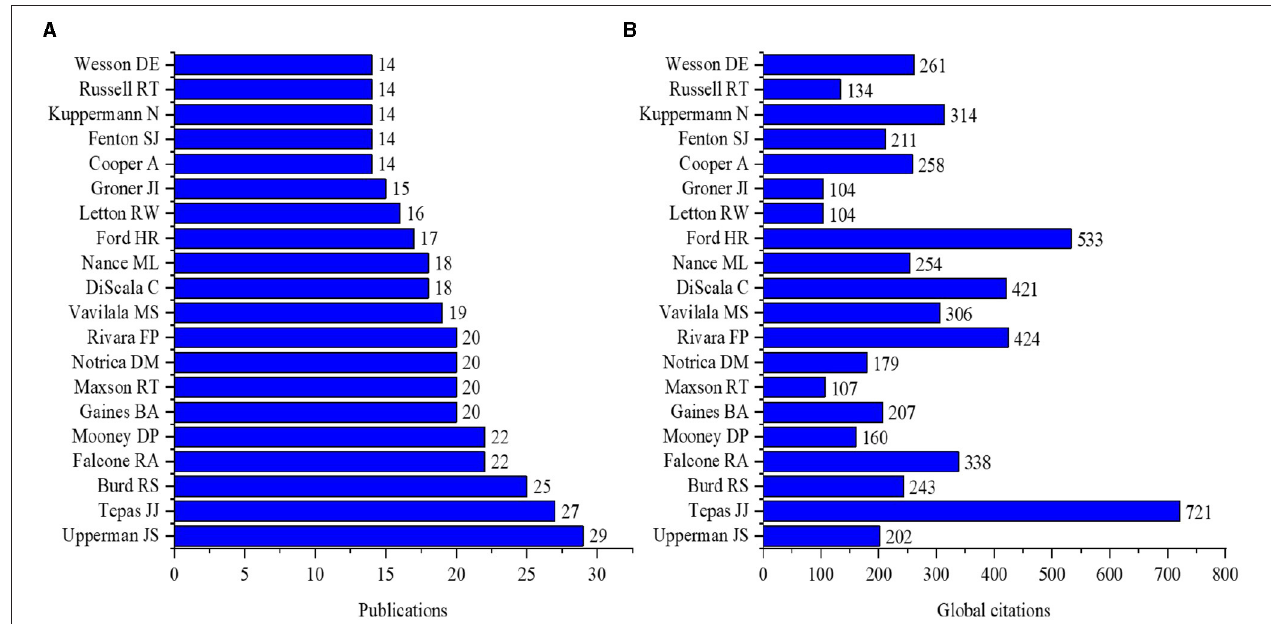
FIGURE 4 | Top 20 authors in pediatric trauma research (A) Publications (B) Global citations.